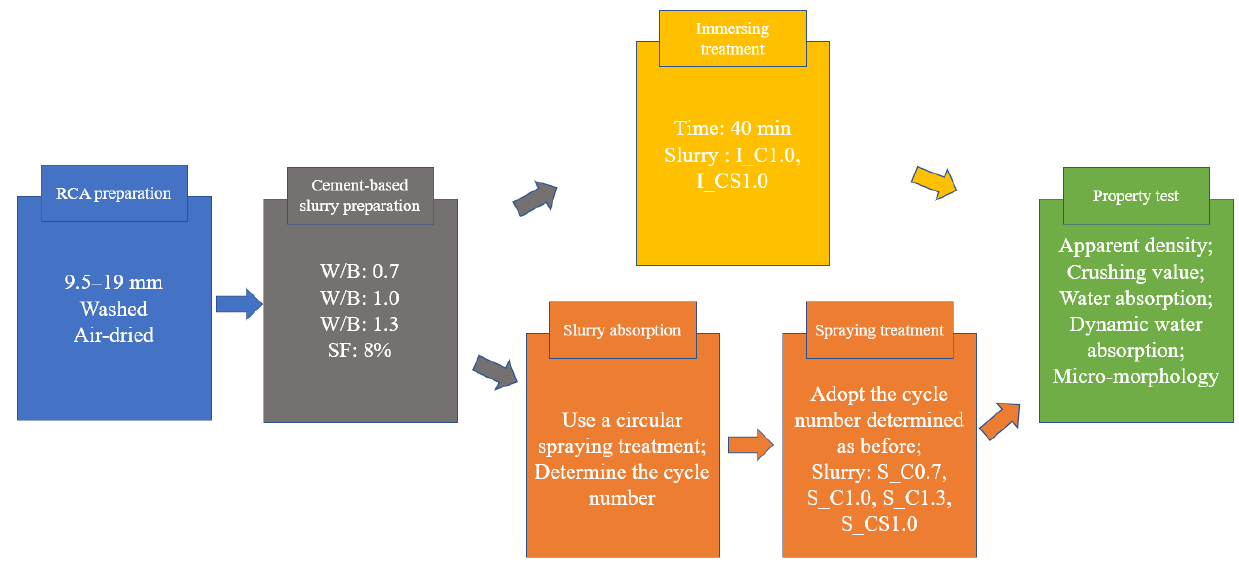
Figure 5. The procedure of the experiment.